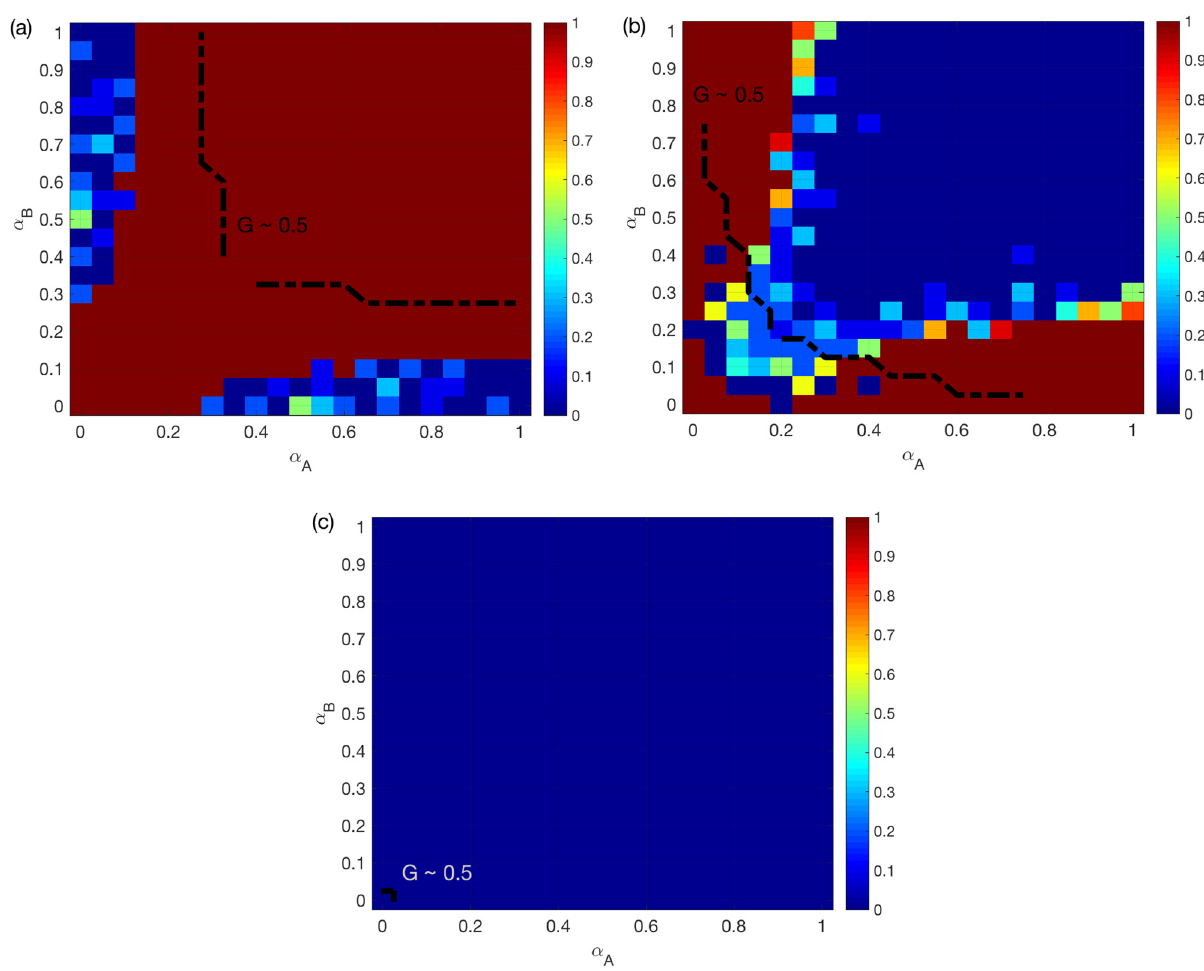
Fig 5. Best choice of overlap ratio r for two SF networks. (a) OR rule. (b) SUM rule. (c) AND rule. N = 500, k A = k B = 6, averagedover M = 90 realizations.The color for certain α A and α B values indicatesthe optimal r that leads to the largest mean G value. A dashedline is added to each sub-figure to indicate the location where the best mean G reaches